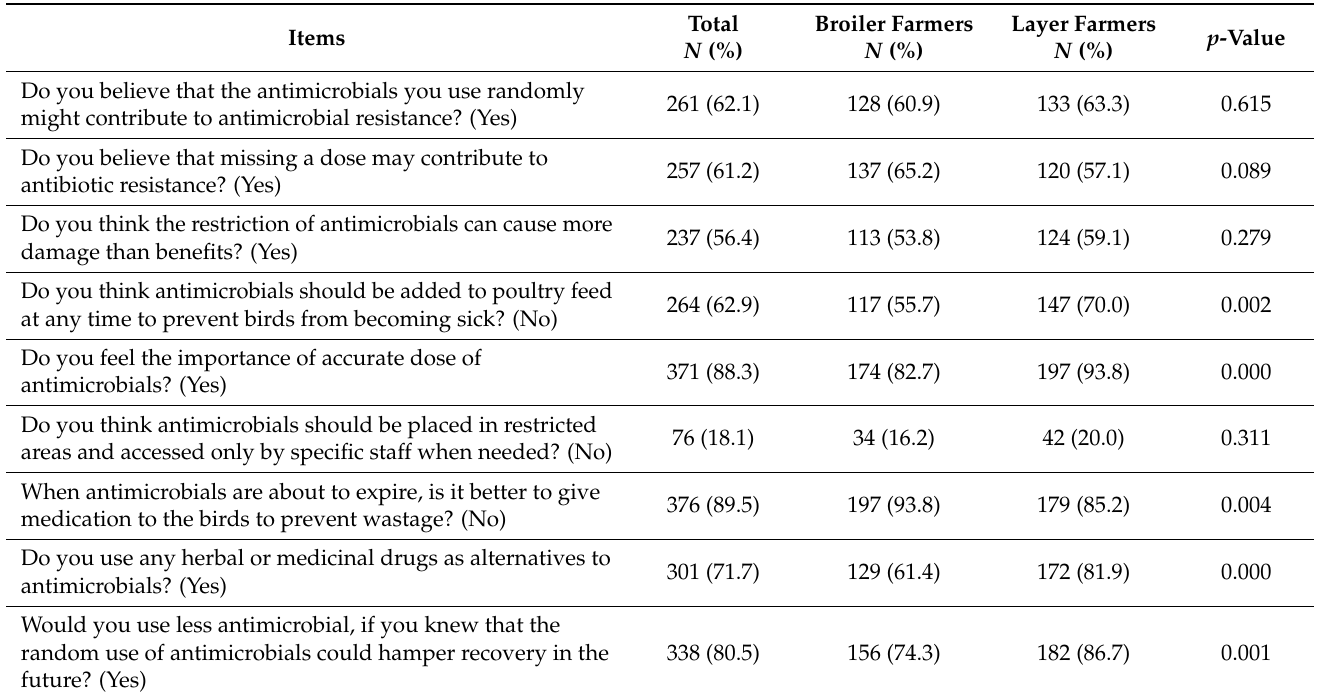
Table 3. Attitudes towards AMU and AMR in broiler and layer